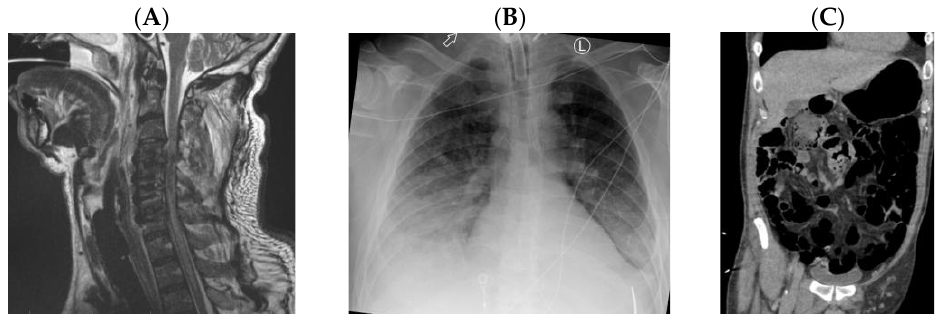
Figure 2. ( A – C ). ( A ) MRI cervical spine demonstrating a spinal cord contusion from C4 to C6. ( B ) Chest X-ray showing bilateral basilar consolidations suggestive of pneumonia and bilateral pleural effusions, which is worse on the right compared to the left. ( C ) CT abdomen and pelvis showing multiple loops of dilated bowel concerning for an ileus.